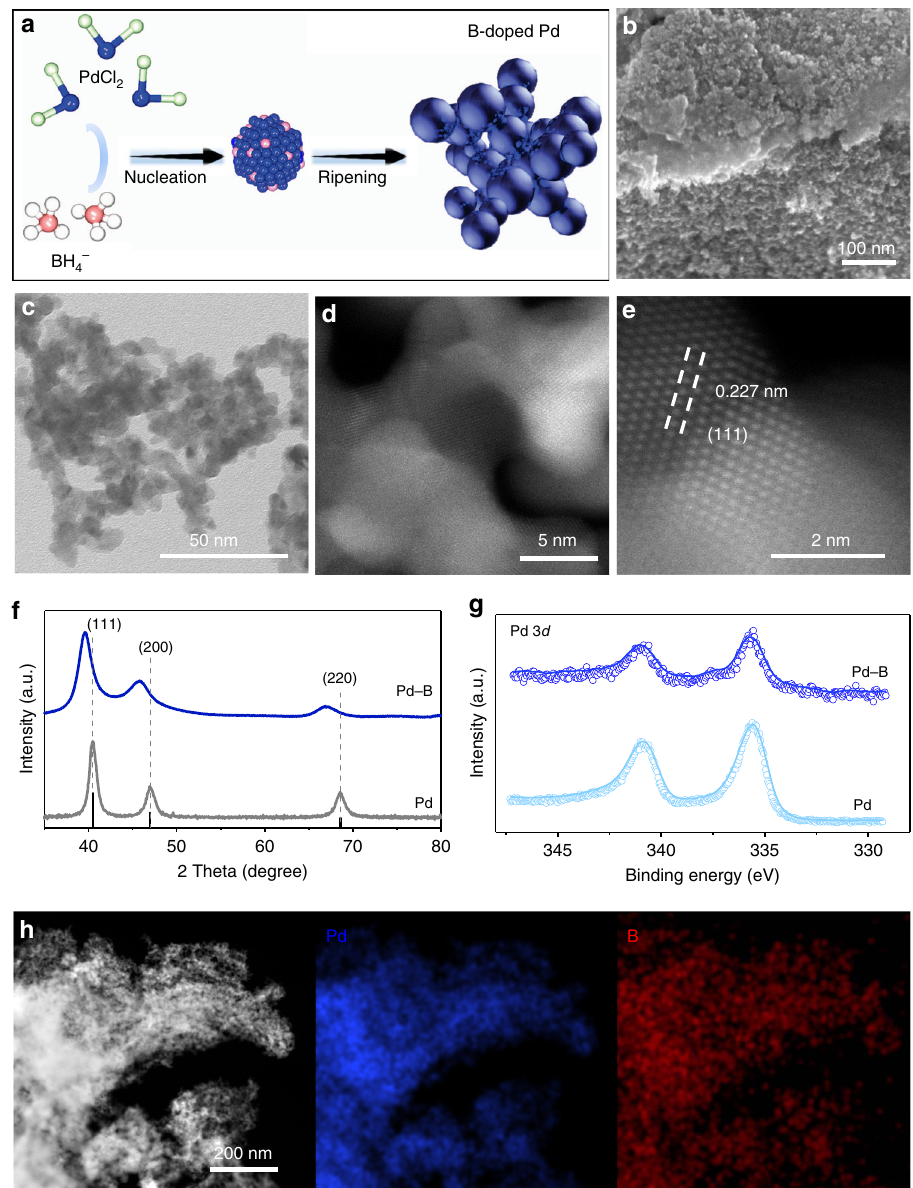
Fig. 2 Catalyst synthesis and structure characterization. a The fabrication schematic illustration of Pd – B catalysts. b SEM, c TEM, d HAADF, and e HAADF- STEM images, showing the morphology and size of Pd – B nanomaterials. f Powder XRD spectra of Pd – B and Pd samples show a peak shift, demonstrating the boron penetration into the Pd lattice. Black line corresponding to JCPDS No. 05-0681. g XPS spectra for Pd 3 d regions. h EELS, showing the homogeneous distribution of Pd and B elements in the Pd – B sample. The scale bar in h is 200